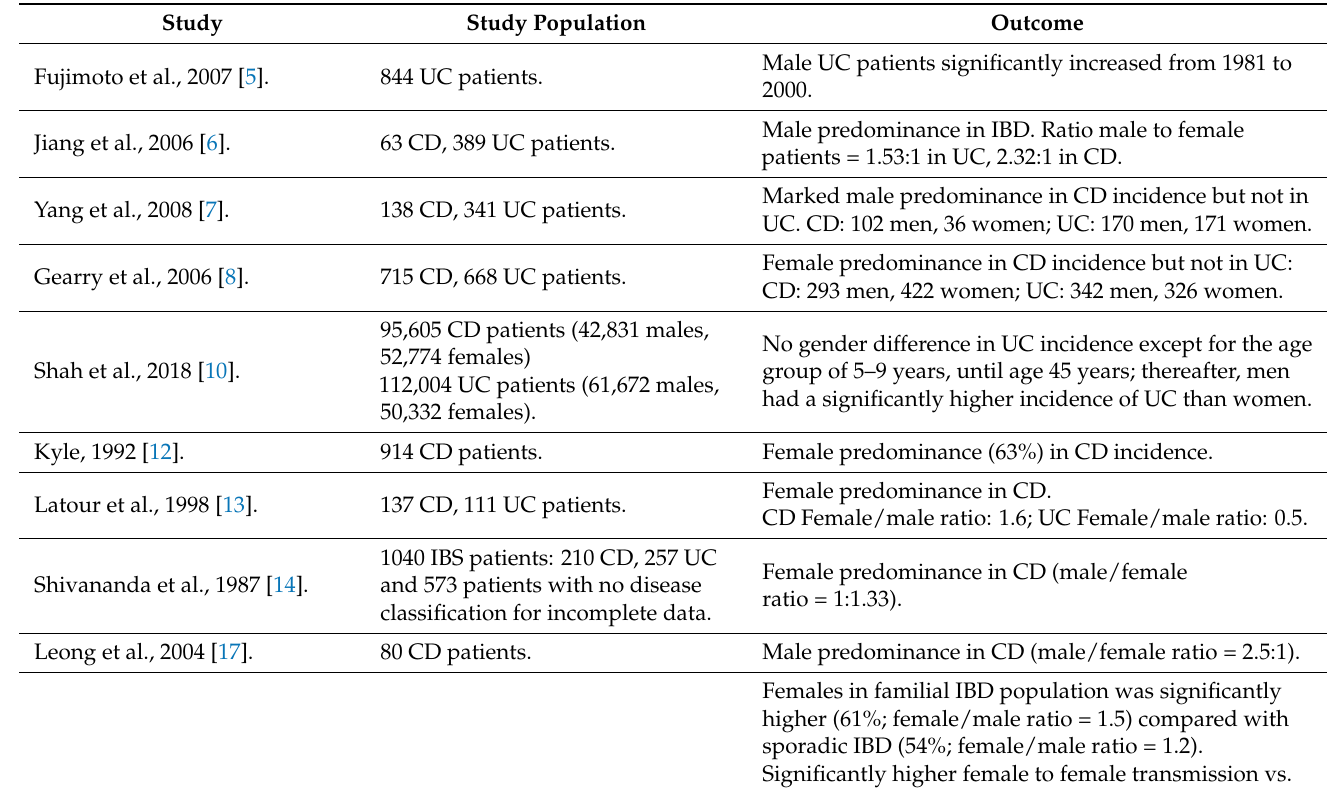
Table 1. Studies assessing the incidence and prevalence of IBD by